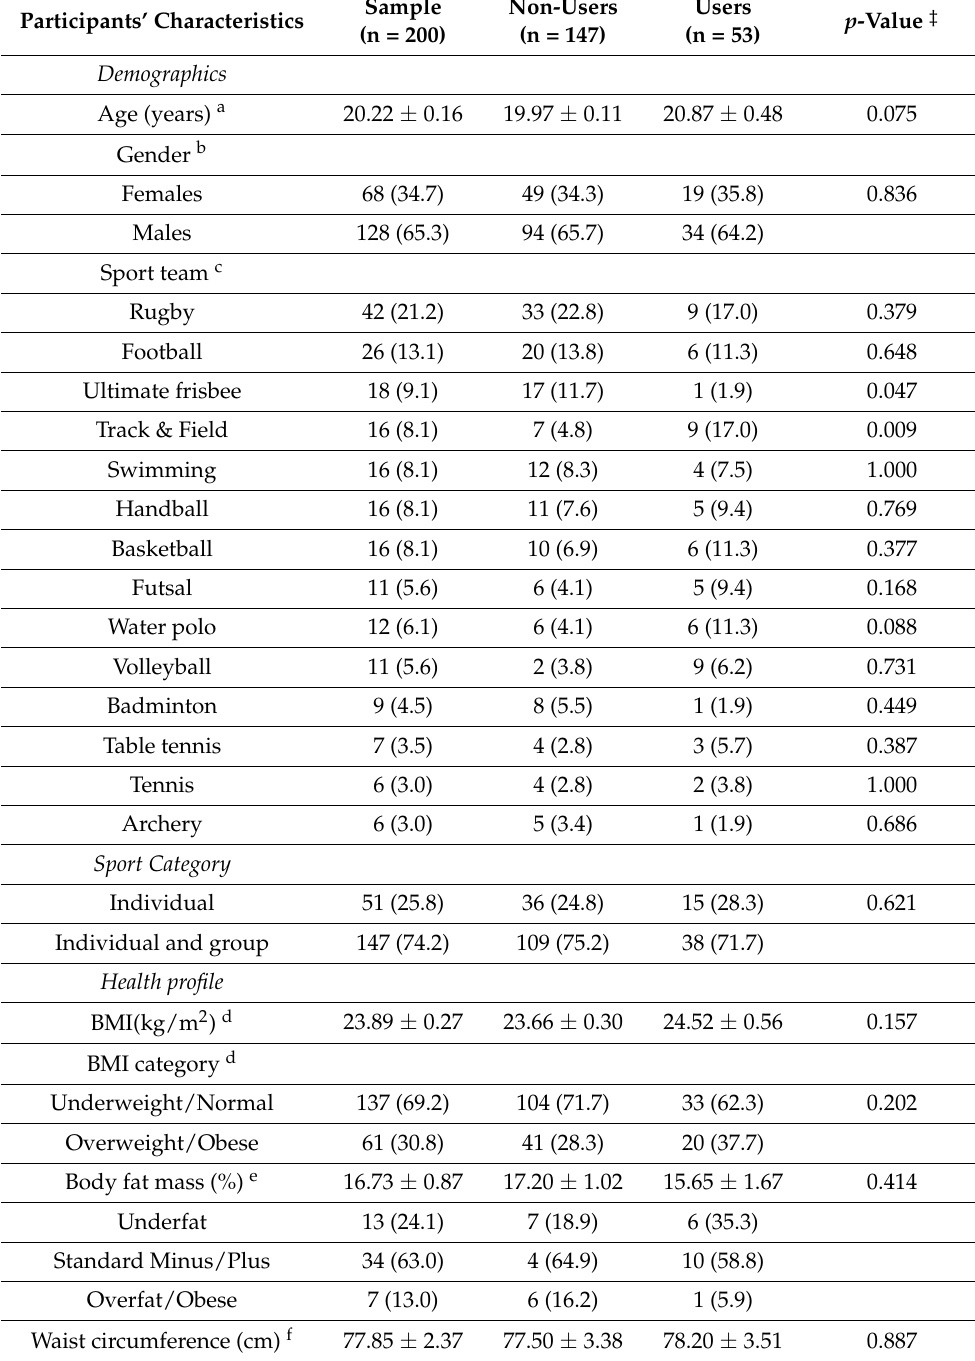
Table 1. Sample characteristics for the total sample among ever users and non-users of wearable devices †